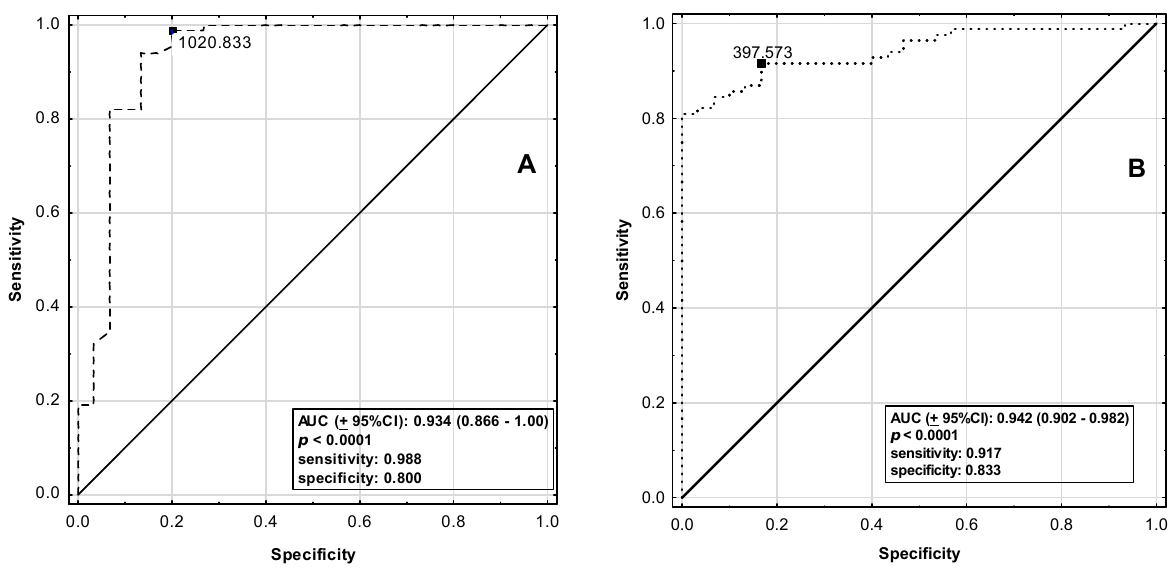
Figure 1. ROC curve for ( A ) ELA and ( B ) AP– 17 as a biomarkers of myocardial infarction (dashed line).